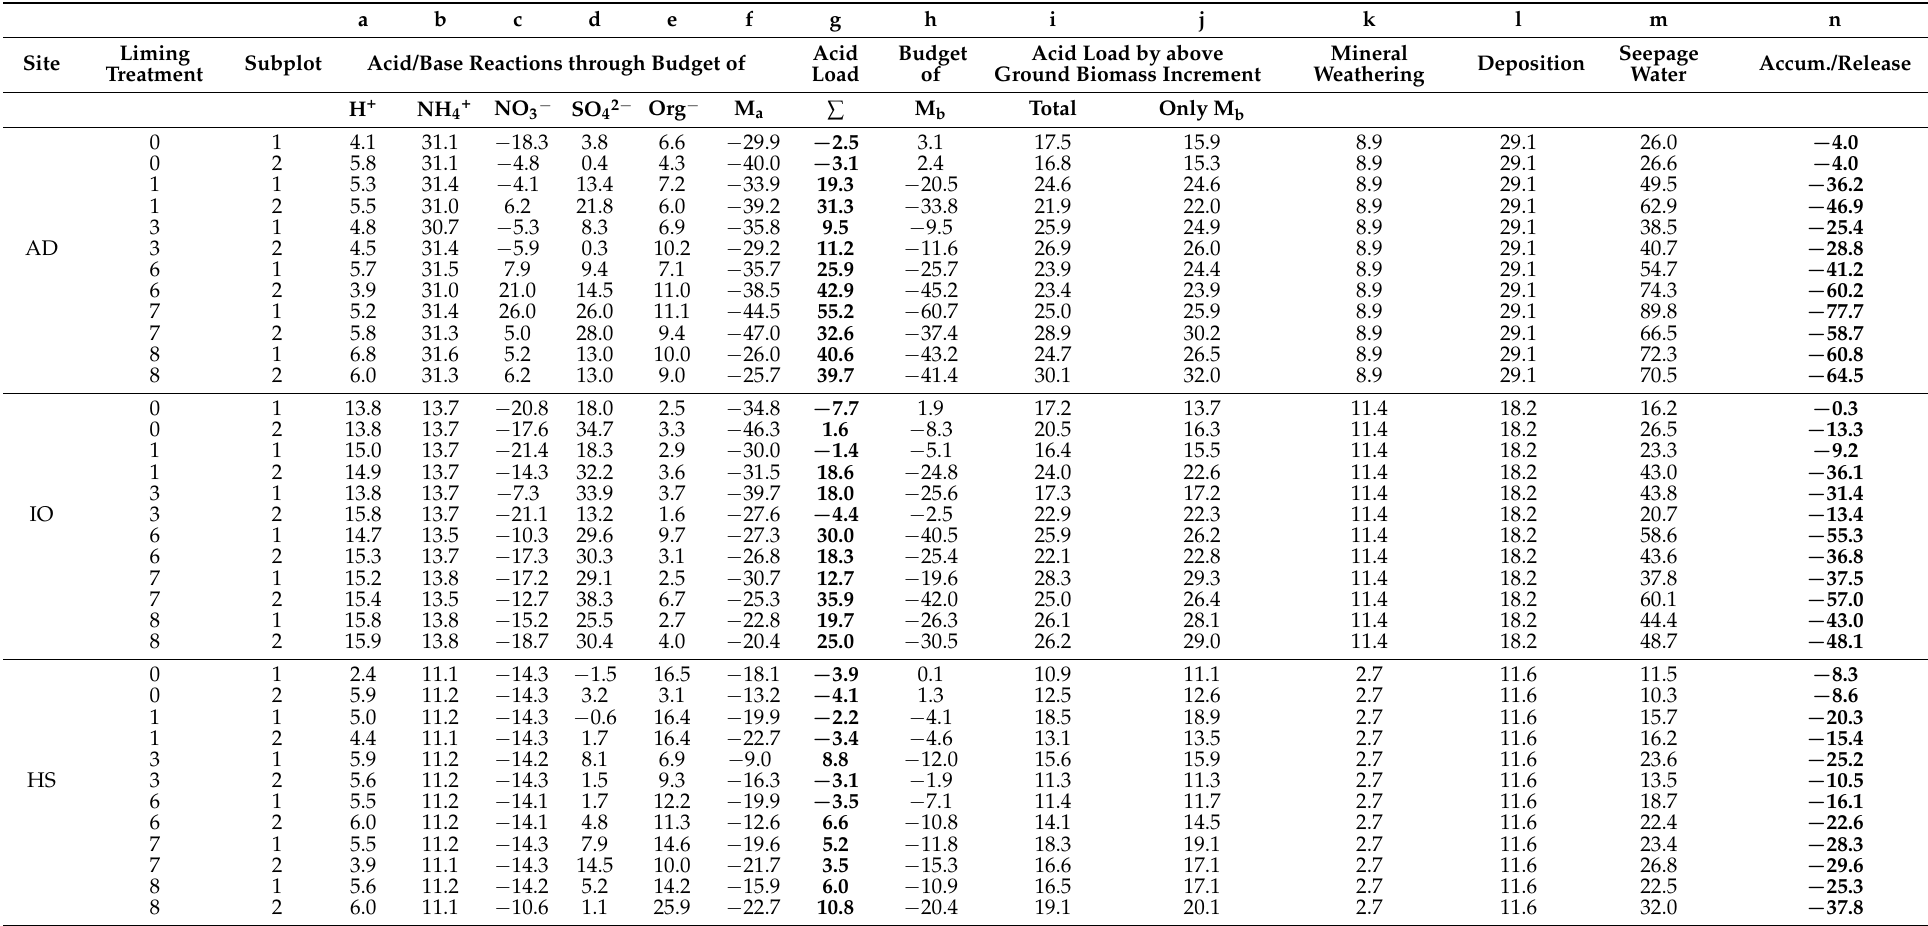
Table 4. Columns a-f and h contain the net proton production (>0)/proton consumption (<0) accumulated over for 24 years (1989 to 2012) [keq ha − 1 24a − 1 ] which is shown separately in Table 3. Column g contains remaining acid load when the M b budget (h) is not included. Columns i-n give a detailed look at the processes involved in the M b budget. M b accumulation